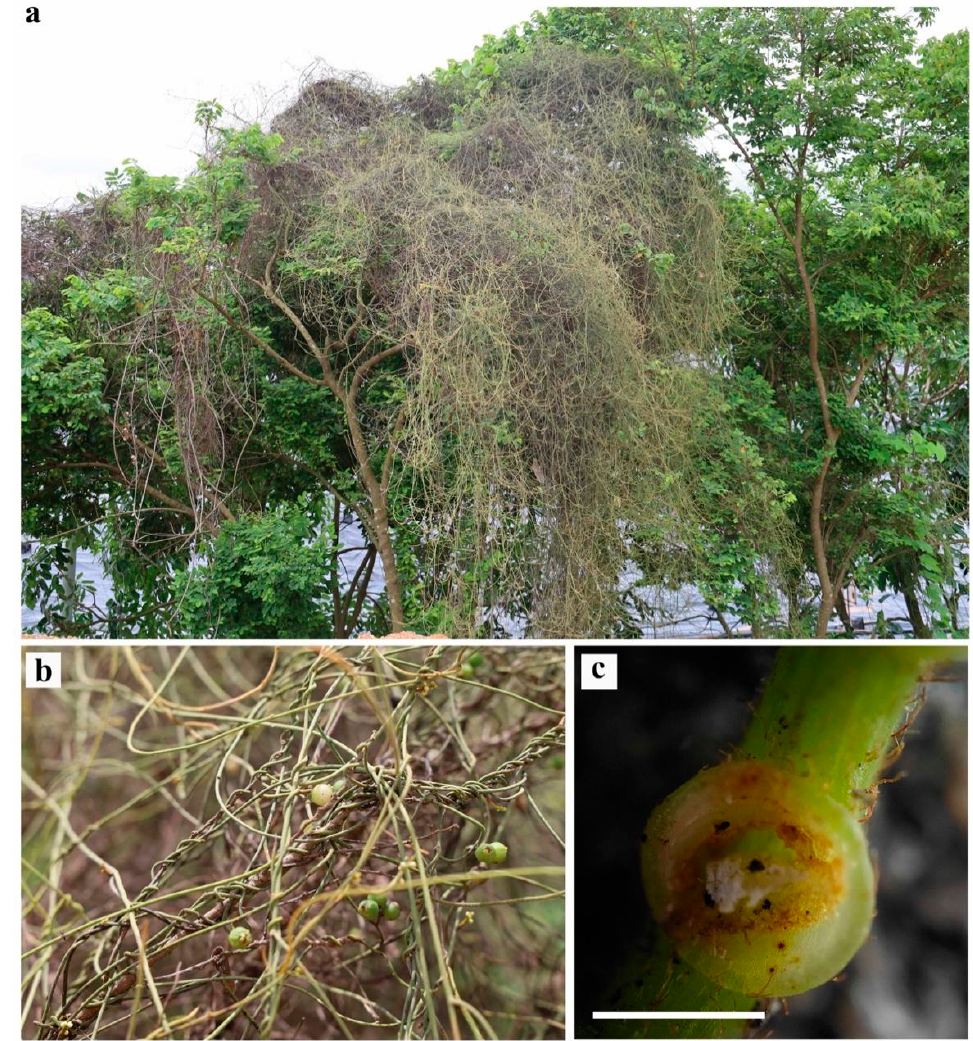
Figure 2. The host Bridelia balansae and Cassytha filiformis with its haustoria. ( a ) Host and C. filiformis collected in Lingshui, Hainan (longitude: 109°55 ′ E, latitude: 18°33 ′ N, altitude: 42 m). ( b ) Vines and collected in Lingshui, Hainan (longitude: 109 ◦ 55 (cid:48) E, latitude: 18 ◦ 33 (cid:48) N, altitude: 42 m). ( b ) Vines and fruits. ( c ) The haustorium. Scale bars = 1 mm. fruits. ( c ) The haustorium. Scale bars = 1